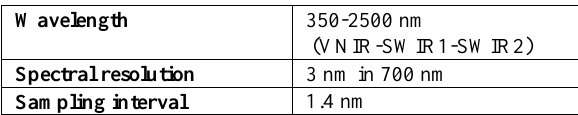
Table 1: Characteristics of the ASD sensor